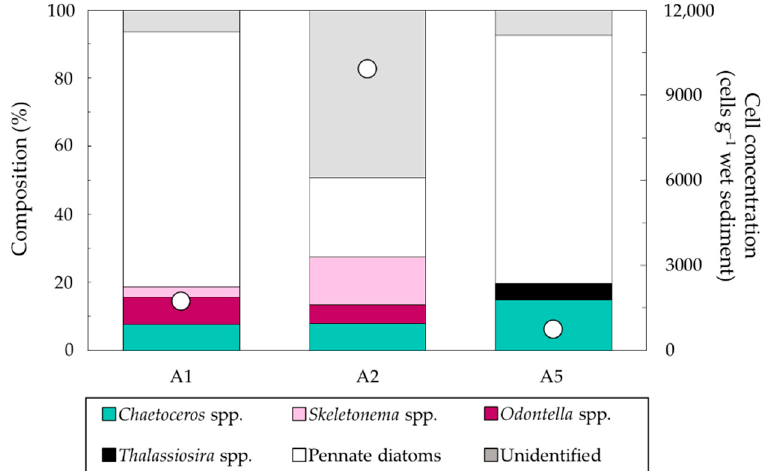
Figure 7. MPN of viable cells and species composition of diatoms in the bottom sediment at A1, A2, and A5; an open circle represents cell concentration.